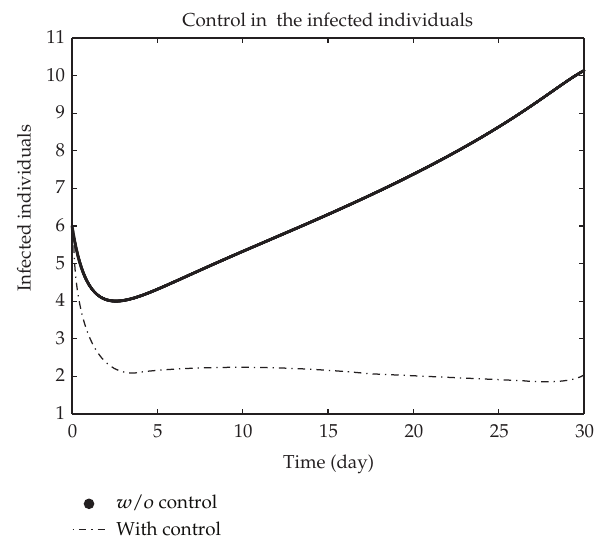
Figure 4: The plot represents the population of infected class with and without